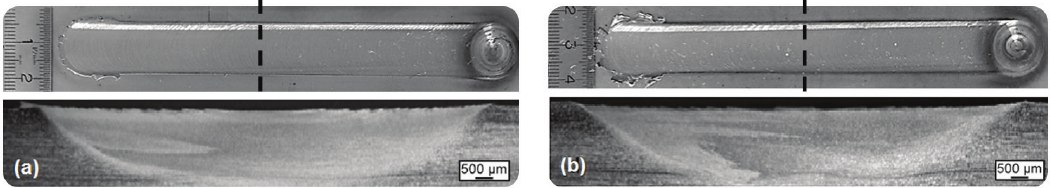
Figure 3. Macrographs of top surface and cross-section of joints: (a) SS-PCBN-500 and (b) SS-PCBN-800. The black lines on the top surfaces indicate the sections of cut.